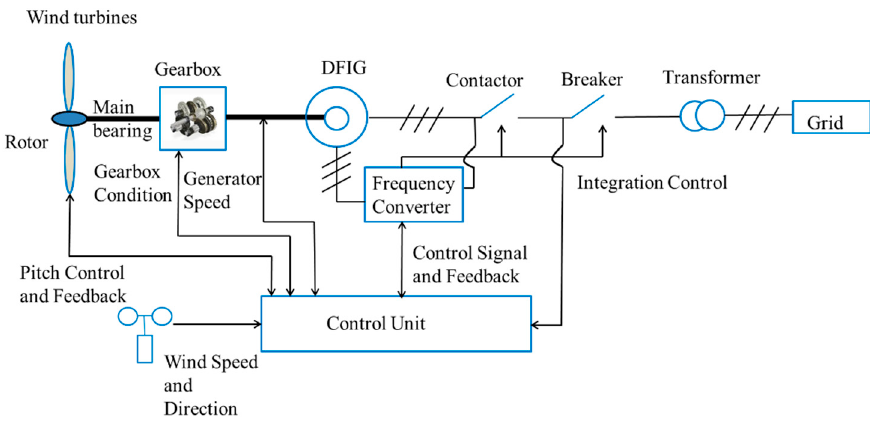
Figure 2. The main structure of a typical wind turbine.